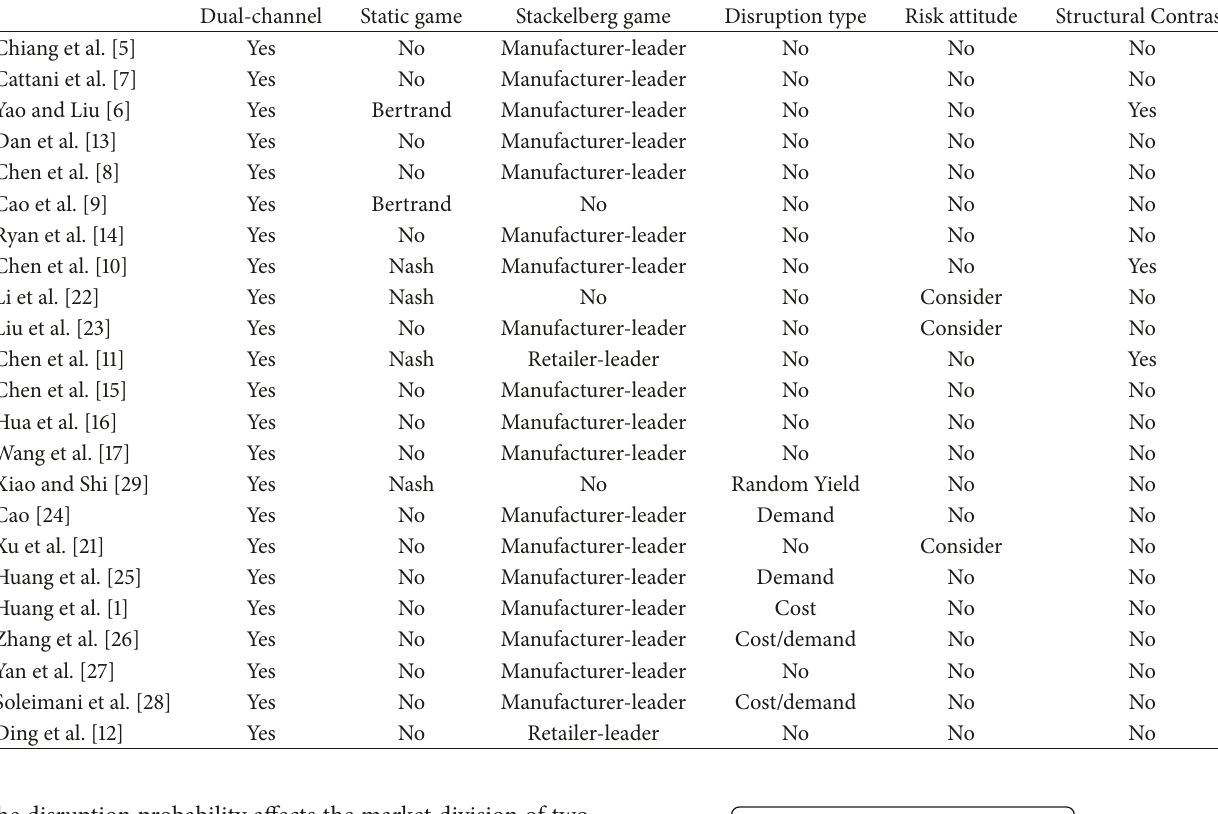
Table 1: Dual-channel supply chain considering pricing or disruption.